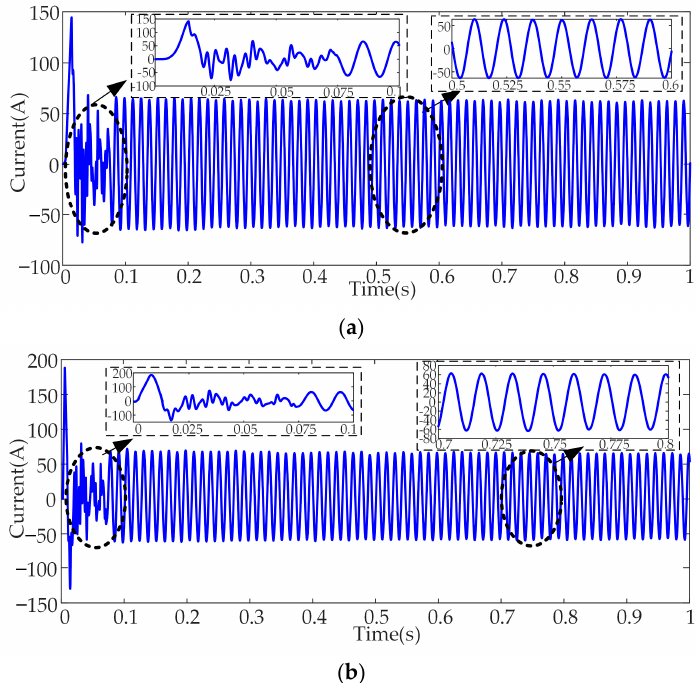
Figure 11. The phase current waveforms under regular incident waves. ( a ) Phase current of G1; ( b ) phase current of G2.